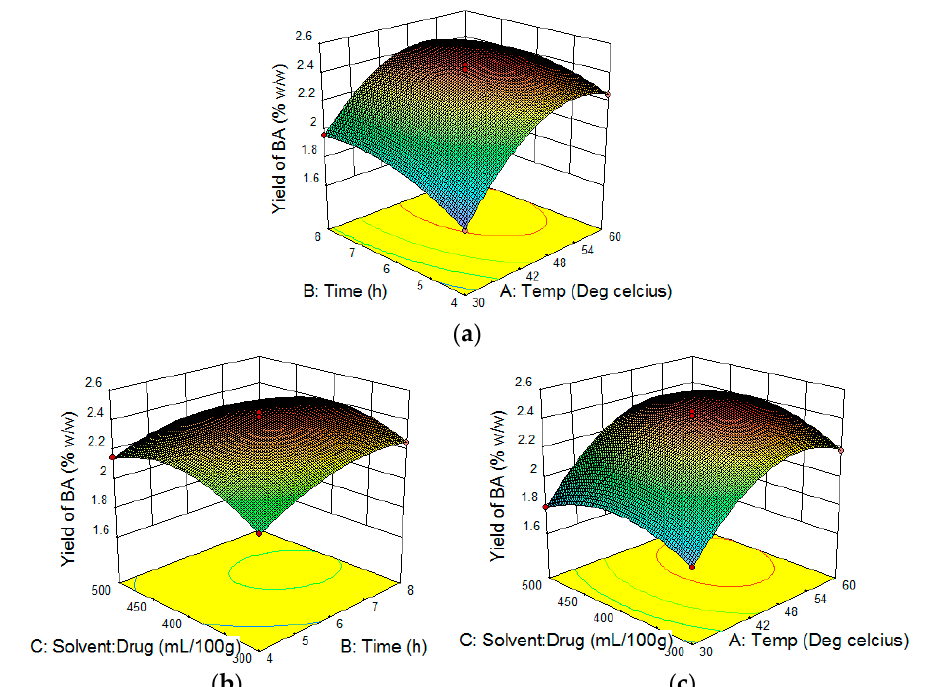
Figure 5. Response surface model 3D plots showing the effects of independent variable of Soxhlet extraction on BA yield: ( a ) temperature and time ( b ) time and solvent to drug ratio ( c ) temperature and solvent to drug ratio.